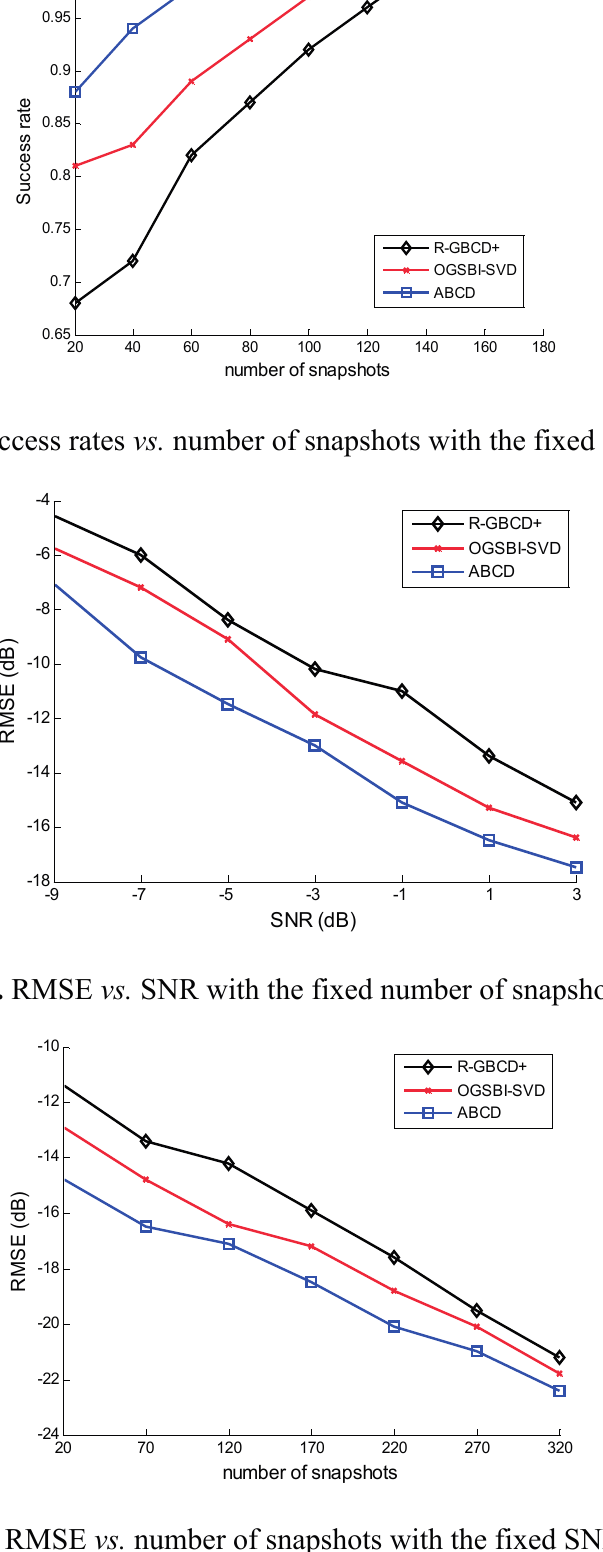
Figure 5. RMSE vs. number of snapshots with the fixed SNR 0